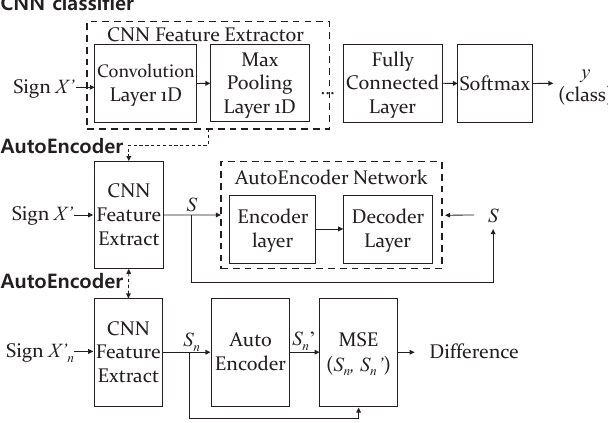
Figure 4. Architecture of the proposed CNN-AE